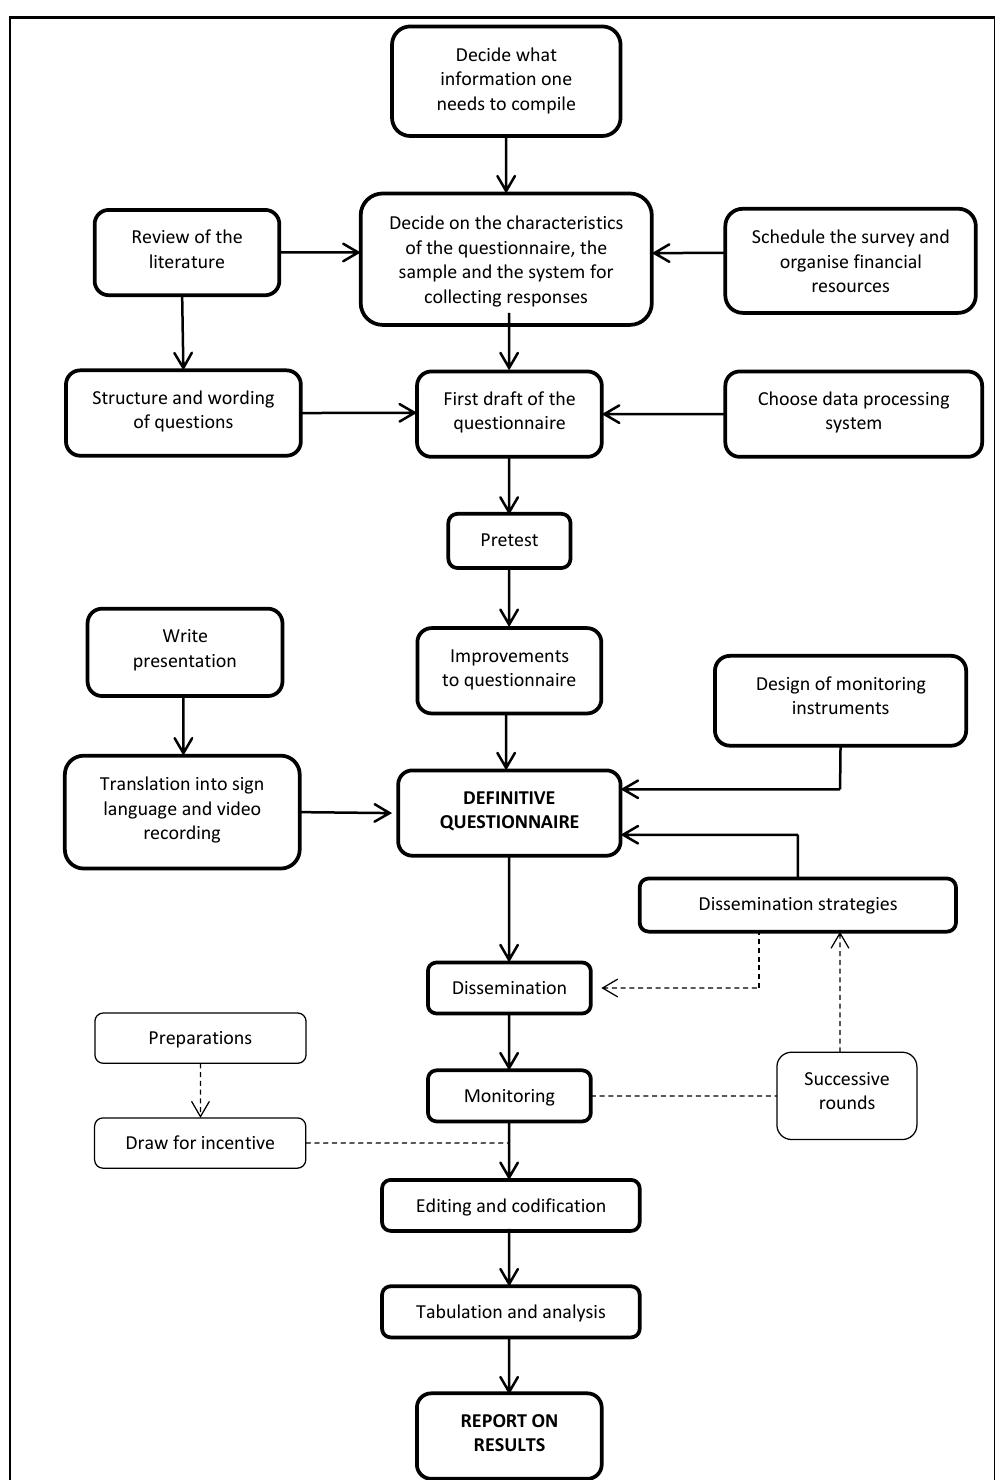
Figure 2. Stages in the development of the questionnaire. Adapted from Research Methods in Education (p.210), by L. Cohen, L. Manion, and K. Morrison, 2007, New York: Routledge. Copyright 2007 by